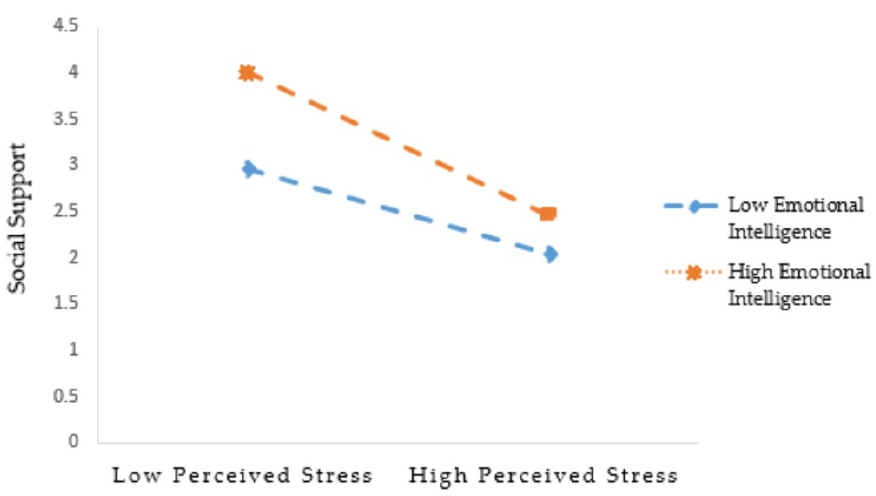
Figure 2. Emotional intelligence moderates the impact of perceived stress on social support. Table 5. The moderating effect of emotional intelligence. Emotional Intelligence